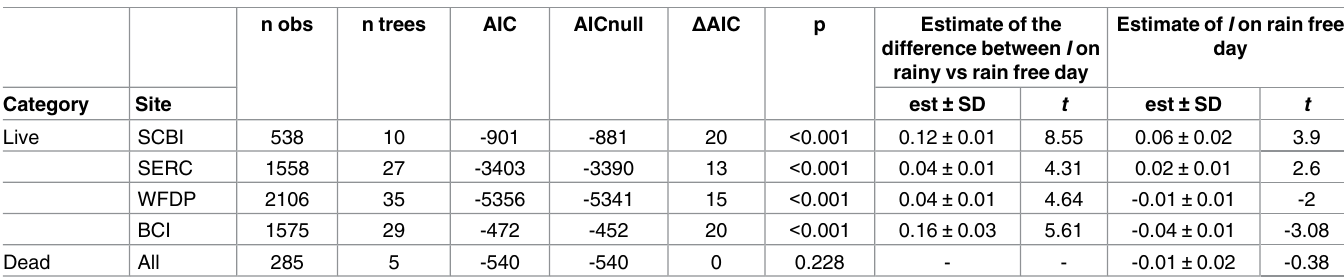
Table 5. Mixed model results for rain effect on I